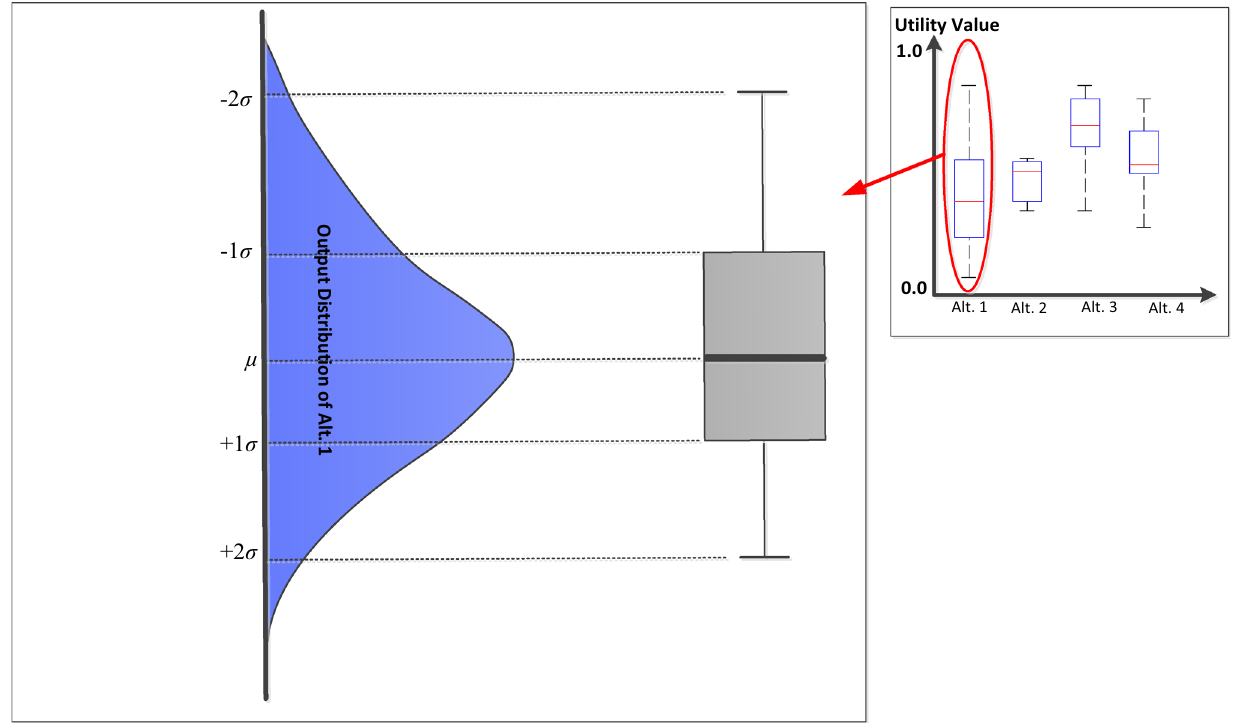
Fig. 3 Relation of the modified box plot to output probability density